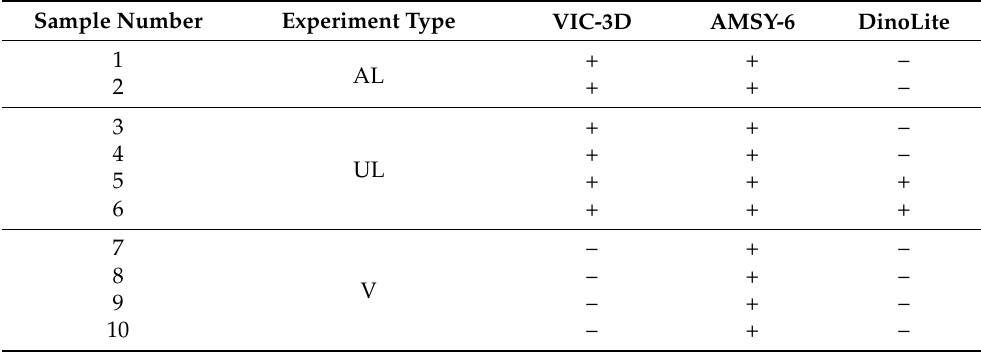
Table 1. Experimental program. AL, active loading; UL, loading with unloadings; V, loading with torsion